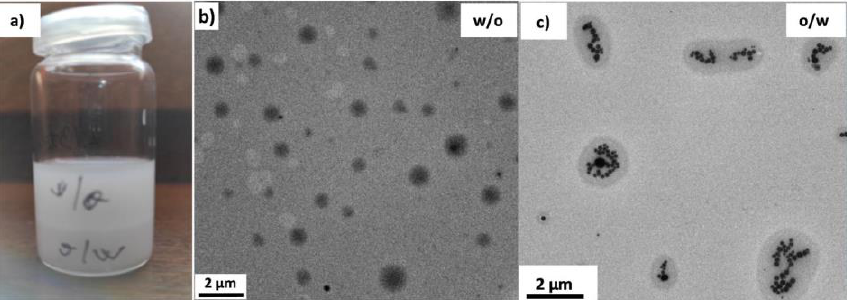
Figure 1. Image ( a ) and morphology of the emulsion obtained with 1 g/L toluene solution of T and water; ( b ) TEM image of the w/o emulsion; ( c ) TEM image of the o/w emulsion. water; ( b ) TEM image of the w/o emulsion; ( c ) TEM image of the o/w